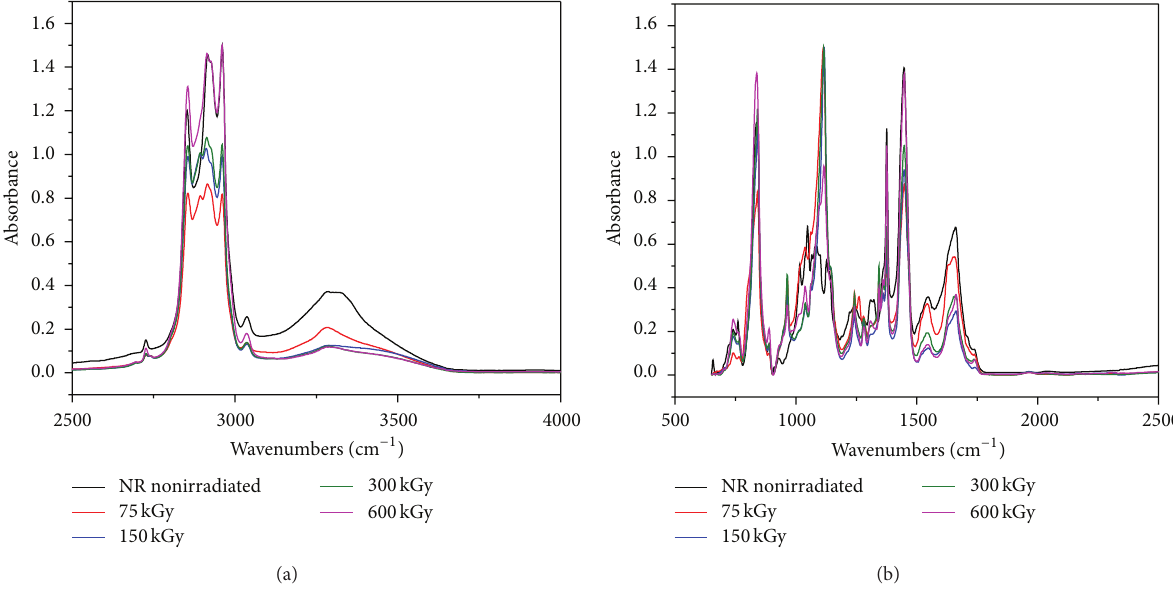
Figure 12: FTIR spectra for NR/hemp mixtures with 10phr hemp content: (a) between 2500–4000 and (b) between